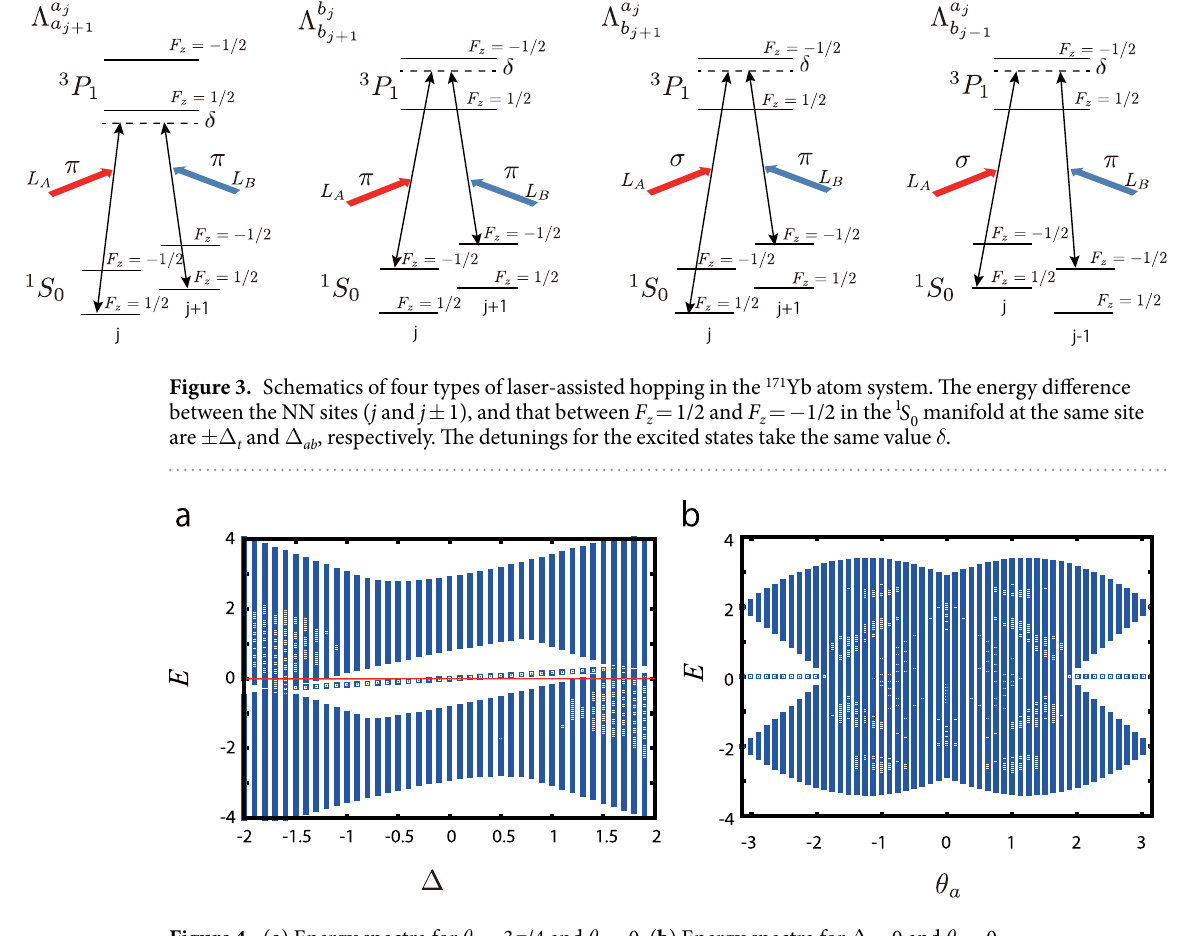
Figure 4. ( a ) Energy spectra for θ a = 3 π /4 and θ b = 0. ( b ) Energy spectra for Δ = 0 and θ b =